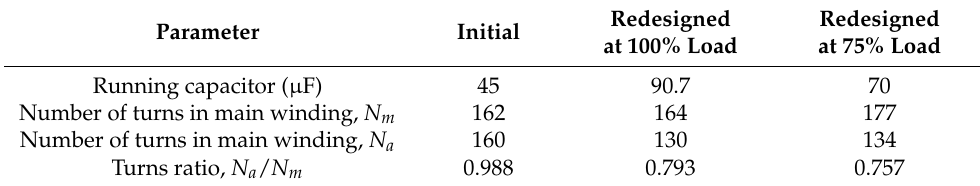
Table 6. The parameters tuning the balanced condition at 100% and 75% loads.